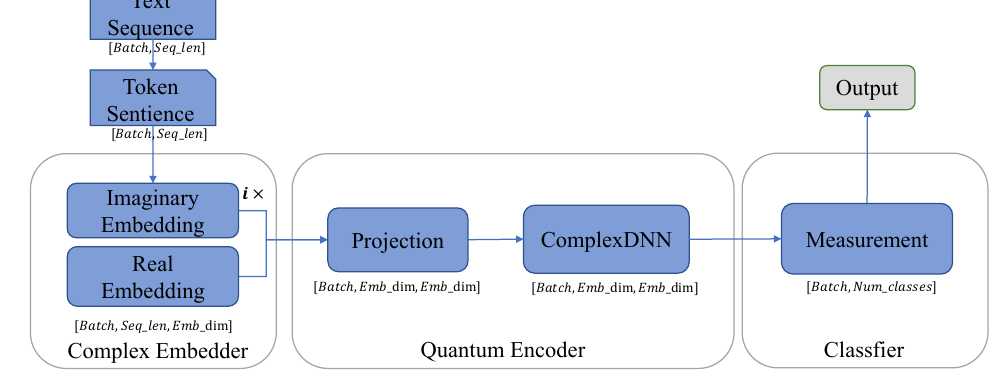
Figure 6. The flow chart of the ComplexQNN for sentiment-classification